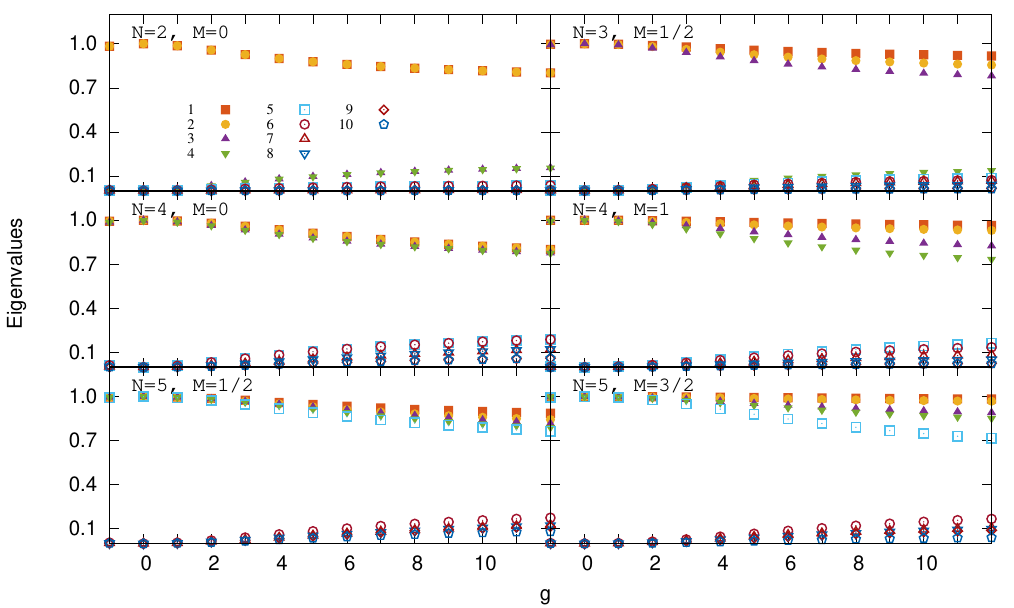
Figure 7. The largest 10 eigenvalues of the one-body density matrix (OBDM) of the ground state of systems with different number of particles and spin configurations as a function of the interaction